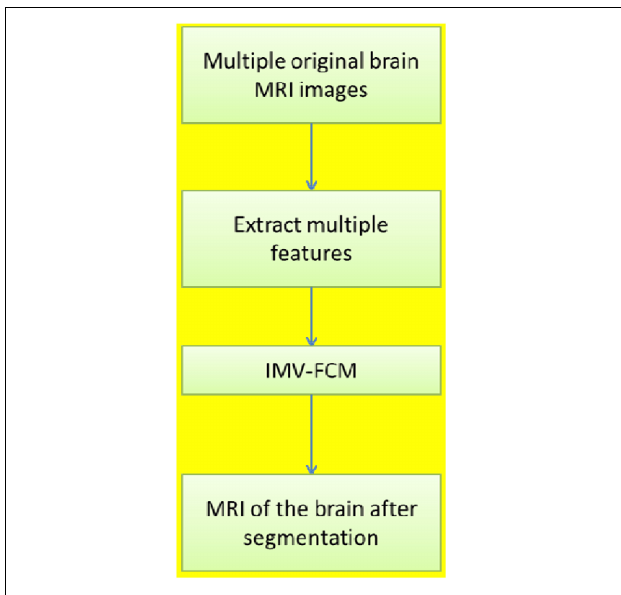
FIGURE 1 | The motivation for this